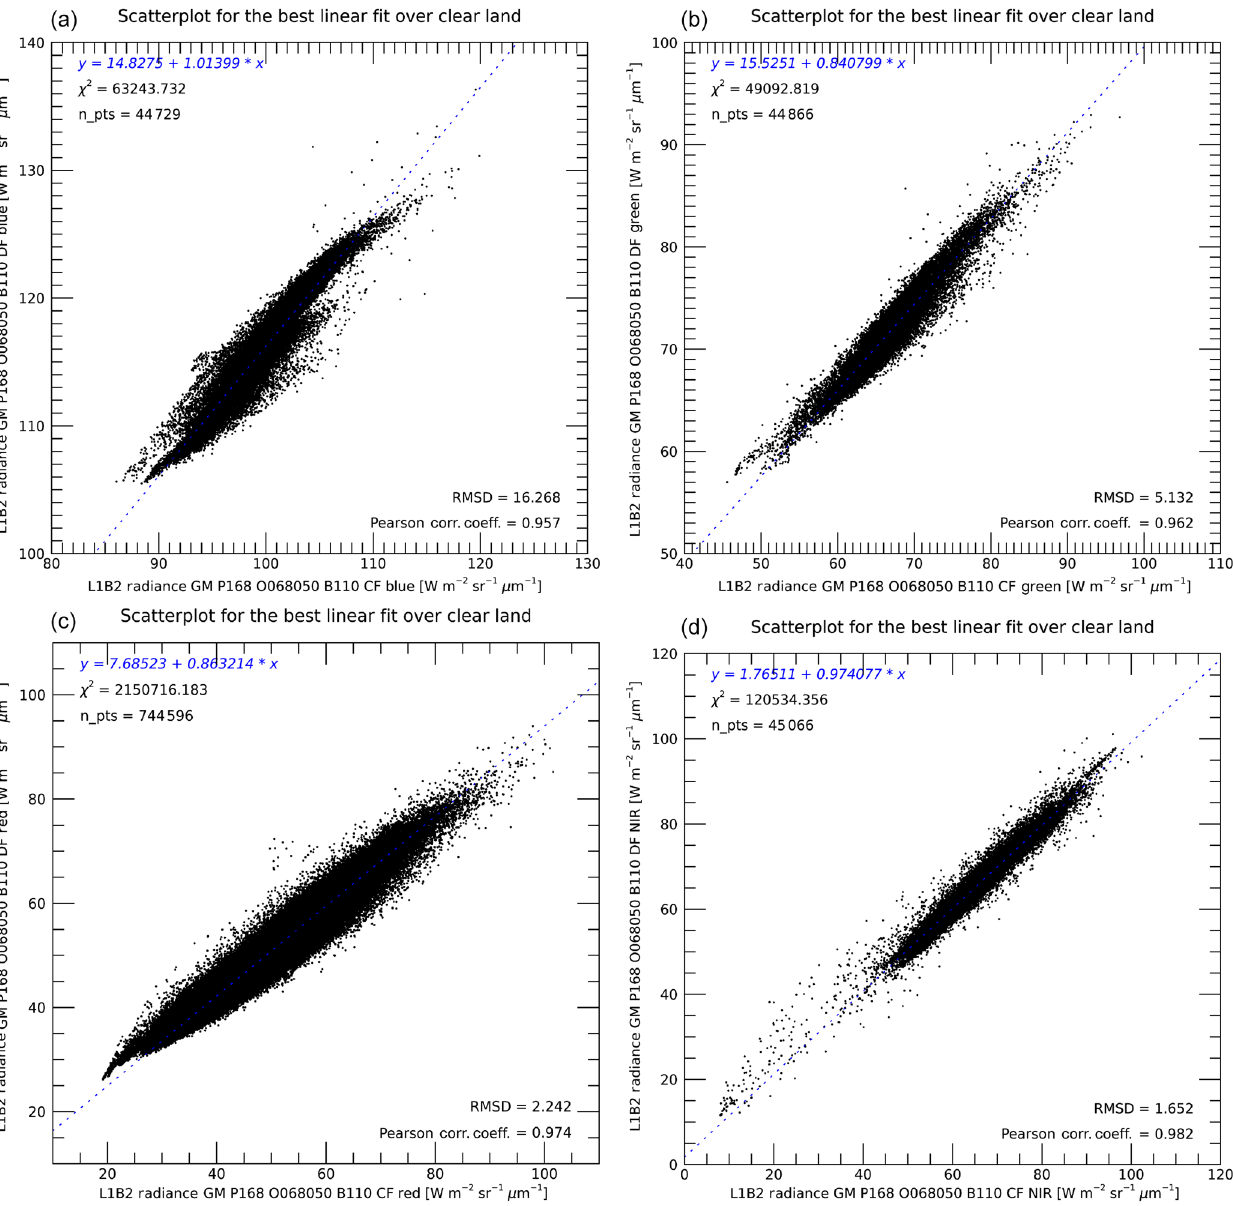
Figure 8. Scatterplots and best linear fit relationships to predict the clear land surface values of the four spectral bands of the DF camera for the G LOBAL M ODE measurements of P ATH 168, O RBIT 68050 and B LOCK 110. In this case, the best predictors for the measurements by the DF camera were those acquired by the CF camera ( a : blue; b : green; c : red; and d : NIR). Note that the ranges of values are different for each plot in order to optimize the view of the